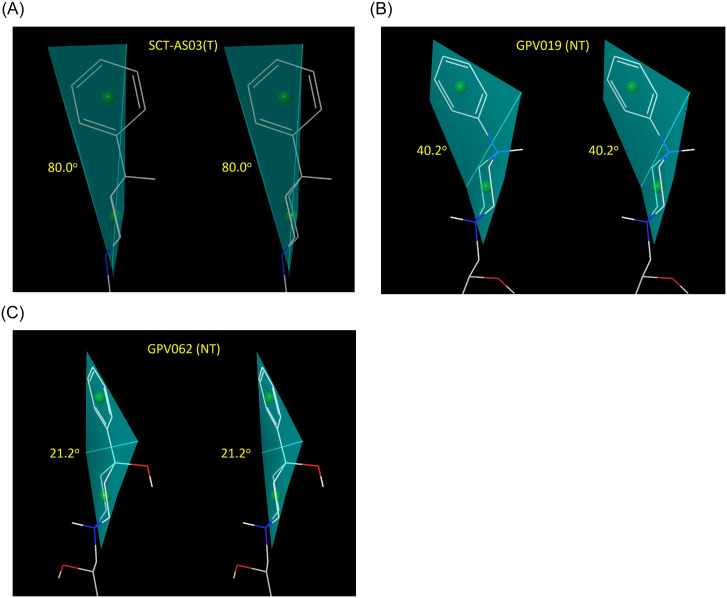
Unambiguous conformational differences are predicted between experimentally identified Trappable (T) and Non-Trappable (NT) propafenone analogs, exemplified by three representative compounds.We hypothesize that in all cases, registration exists between the phenyl group and the putative constriction zone in the closed channel, and furthermore that specific blocker conformational properties are required in this region. (A) The phenyl group of the trappable analog, SCT-AS03, exists in an approximately orthogonal conformation relative to the attached piperidine ring (~80°), resulting in a quasi-linear longitudinal axis in this region that putatively coincides with the pore axis in the bound state. (B) The phenyl and piperazine groups of the non-trappable analog GPV019 are relatively coplanar, and tilted off-axis by ~40° (putatively projecting away from the pore axis in the bound state). (C) A similar coplanar relationship exists between phenyl and hydroxy-substituted piperidine in the non-trappable analog GPV062, which is likewise tilted off-axis by ~20°.